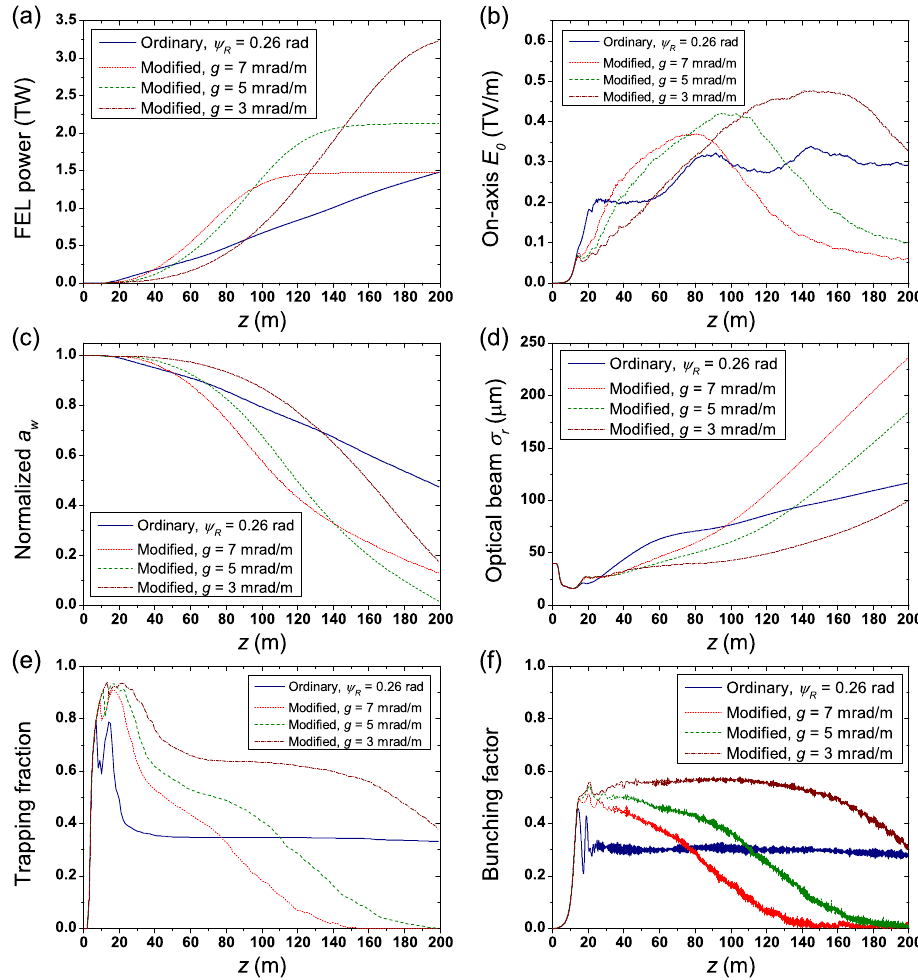
FIG. 1. Evolution of various parameters along the undulator line for the MAX IV FEL case. The parameters are (a) the FEL power, (b) the on-axis optical field amplitude, (c) the a parameter normalized to its initial value, (d) the rms radius of the optical beam, (e) the w trapping fraction, and (f) the bunching factor. The four curves shown in each plot are the results of the ordinary KMR method with ψ ¼ 0 . 26 rad and the modified KMR method with g ¼ 3 , 5 and 7 mrad = R